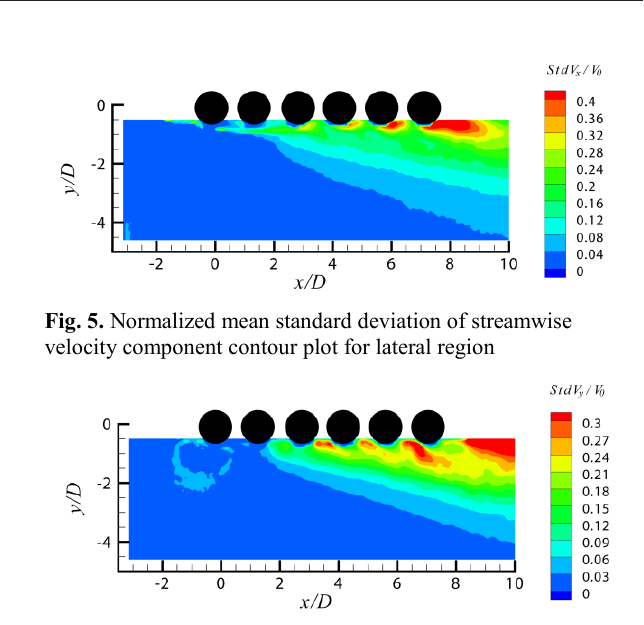
Fig. 6. Normalized mean standard deviation of transverse